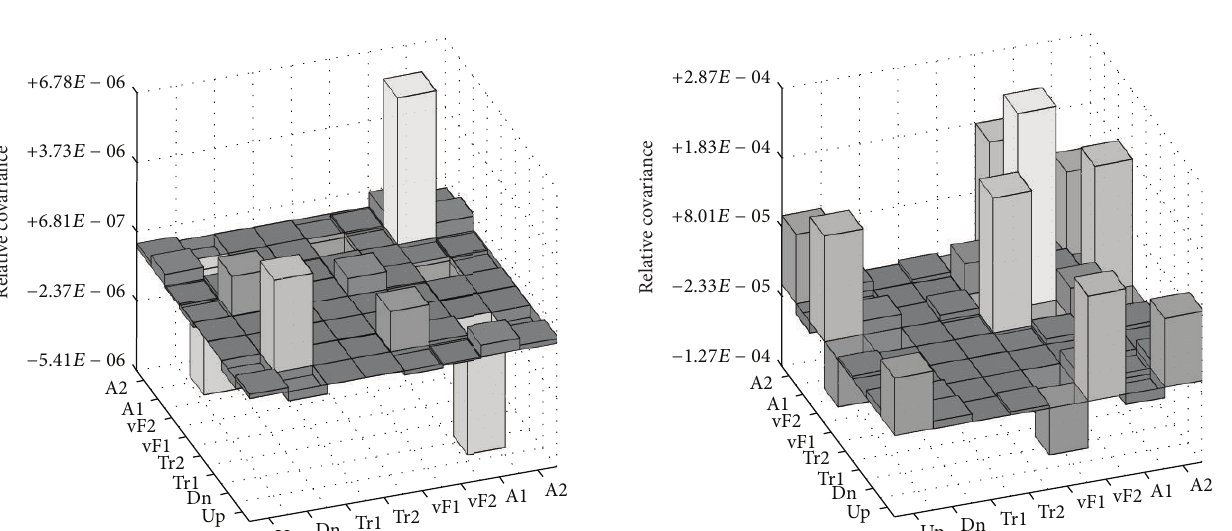
Figure 28: Homogenized property covariance due to 𝜎 U 235 𝛾 covari- ance using TMC.